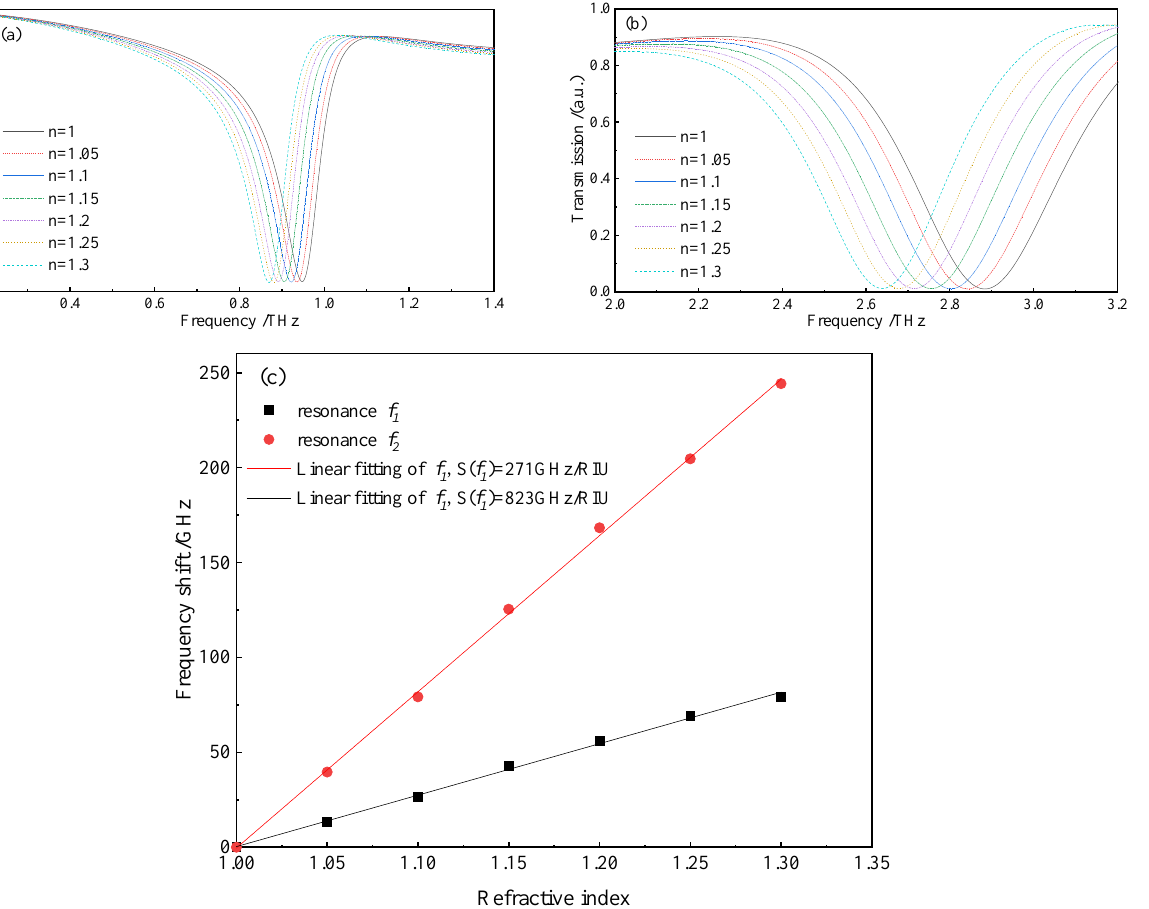
Figure 4. The transmission spectra of the THz MM sensor at ( a ) f 1 and ( b ) f 2 with changing n from 1.0 to 1.3; ( c ) resonance frequency shift of the sensor as a function of n and the linear fitting results. To further investigate the influence of analytes on the refractive index sensitivity of the proposed sensor, different thicknesses of the analyte layer (from 2 to 22 µ m with the step length of 4 µ m) were numerically simulated. Figure 5a,b exhibit the relationship between the resonant frequency shift and the refractive indices for different thickness analytes at resonant frequencies f 1 and f 2 , respectively. As shown in the figures, the sensitivity increased from 188 GHz/RIU to 271 GHz/RIU for resonance 1 and from 573 GHz/RIU to 823 GHz/RIU for resonance 2 when the value of t was changed from 2 to 6 µ m. Namely, as the thickness of the analyte layer increased, the refractive index sensitivity of the sensor significantly increased. However, after t ≥ 10 µ m, this increase in refractive index sensitivity was no longer evident and even decreased, because the analyte thickness was beyond the range of distance that electromagnetic resonance affected, which alterna- tively affected the sensing performance of the sensor. Thus, it was necessary to select a suitable analyte thickness during detection, which was of practical significance for im- proving the sensitivity of the sensor. 1.00